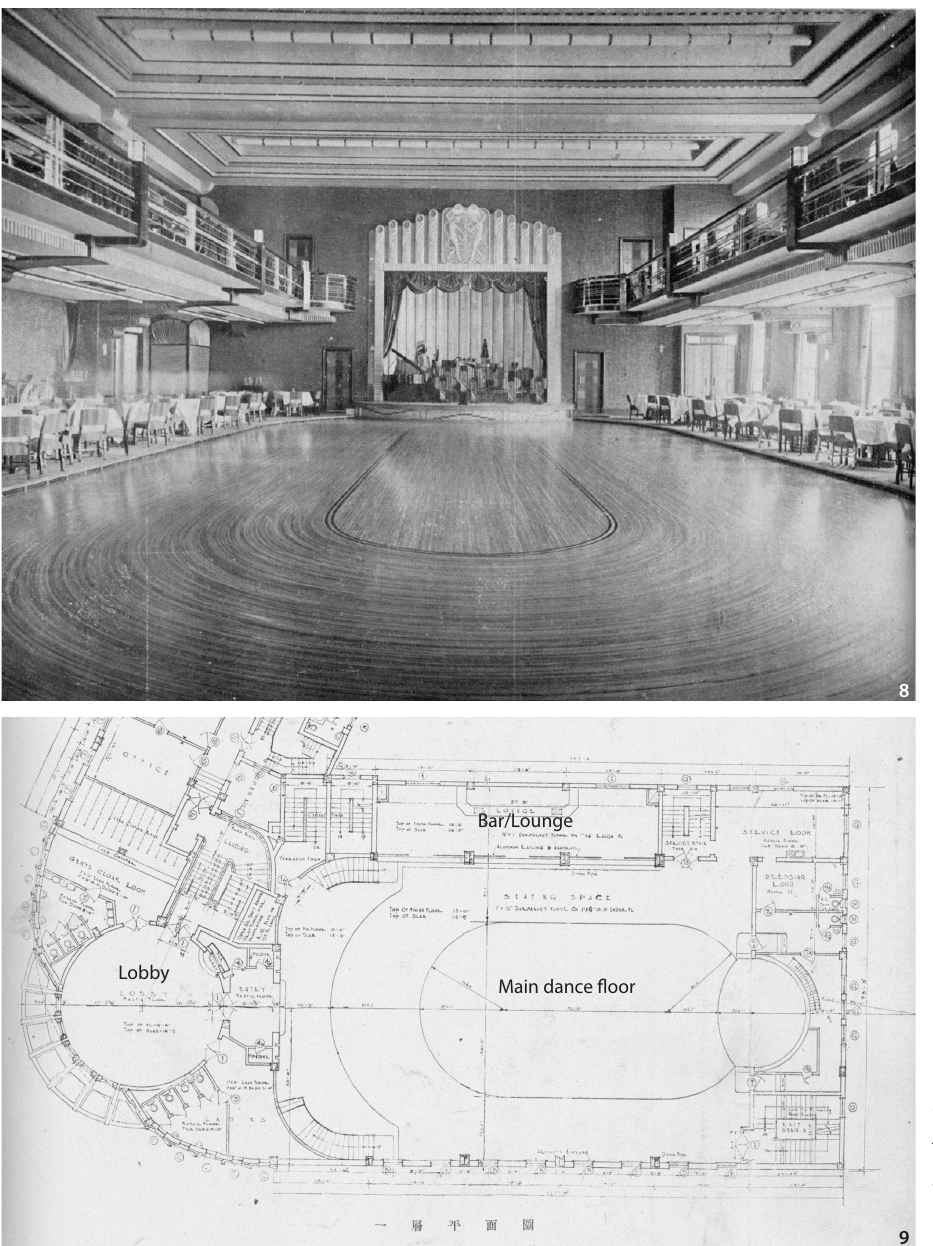
Figure 8 The main dance floor of the Paramount Ballroom (Source: Zhongguo Jianzhu 1934). Figure 9 Blueprint of the first floor of the Paramount Ballroom (Source: Zhongguo Jianzhu